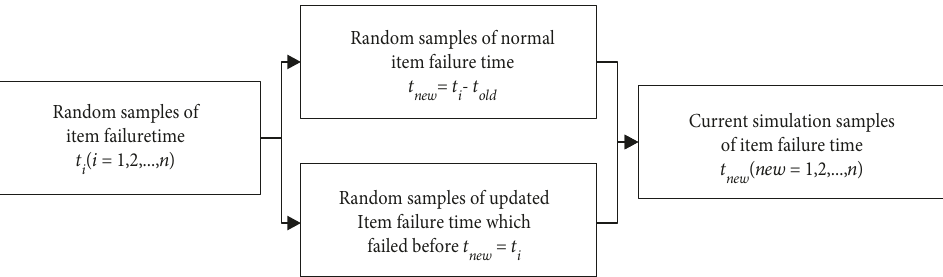
Figure 13: Modi fi cation of the process of dynamic prediction simulation. Table 5: Related unit service times.